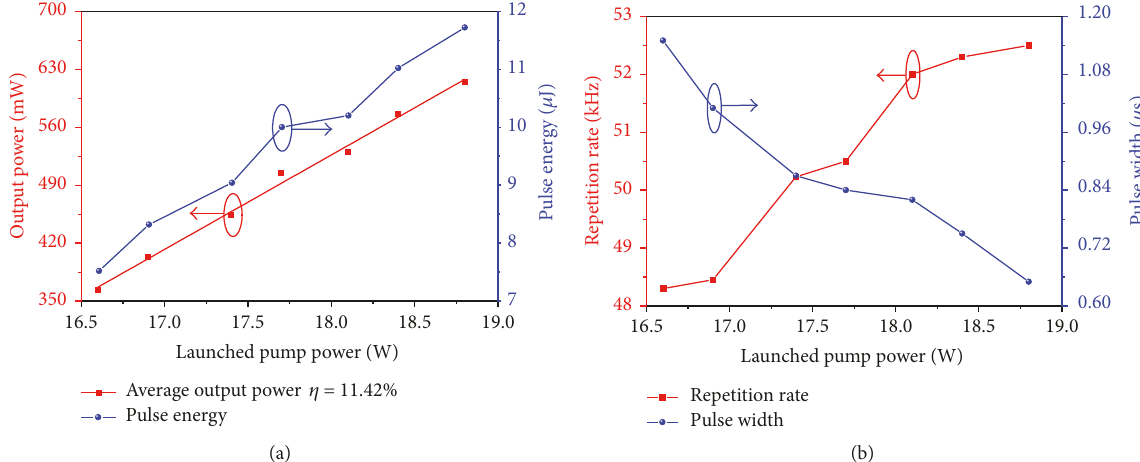
Figure5:(a)Averageoutputpowerandpulseenergyversusthelaunchedpumppower.(b)Repetitionrateandpulsewidthversusthelaunched pump